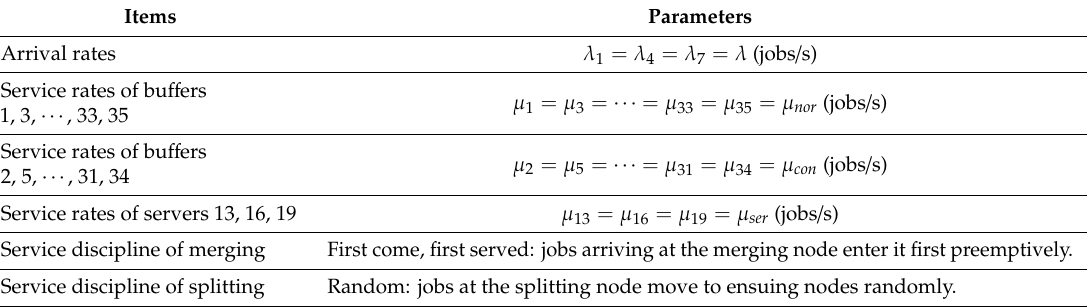
Table 4. Input parameters of experiment 2.